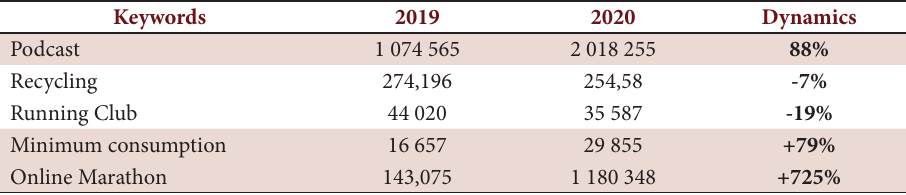
Table 1. Examples of keyword query dynamics